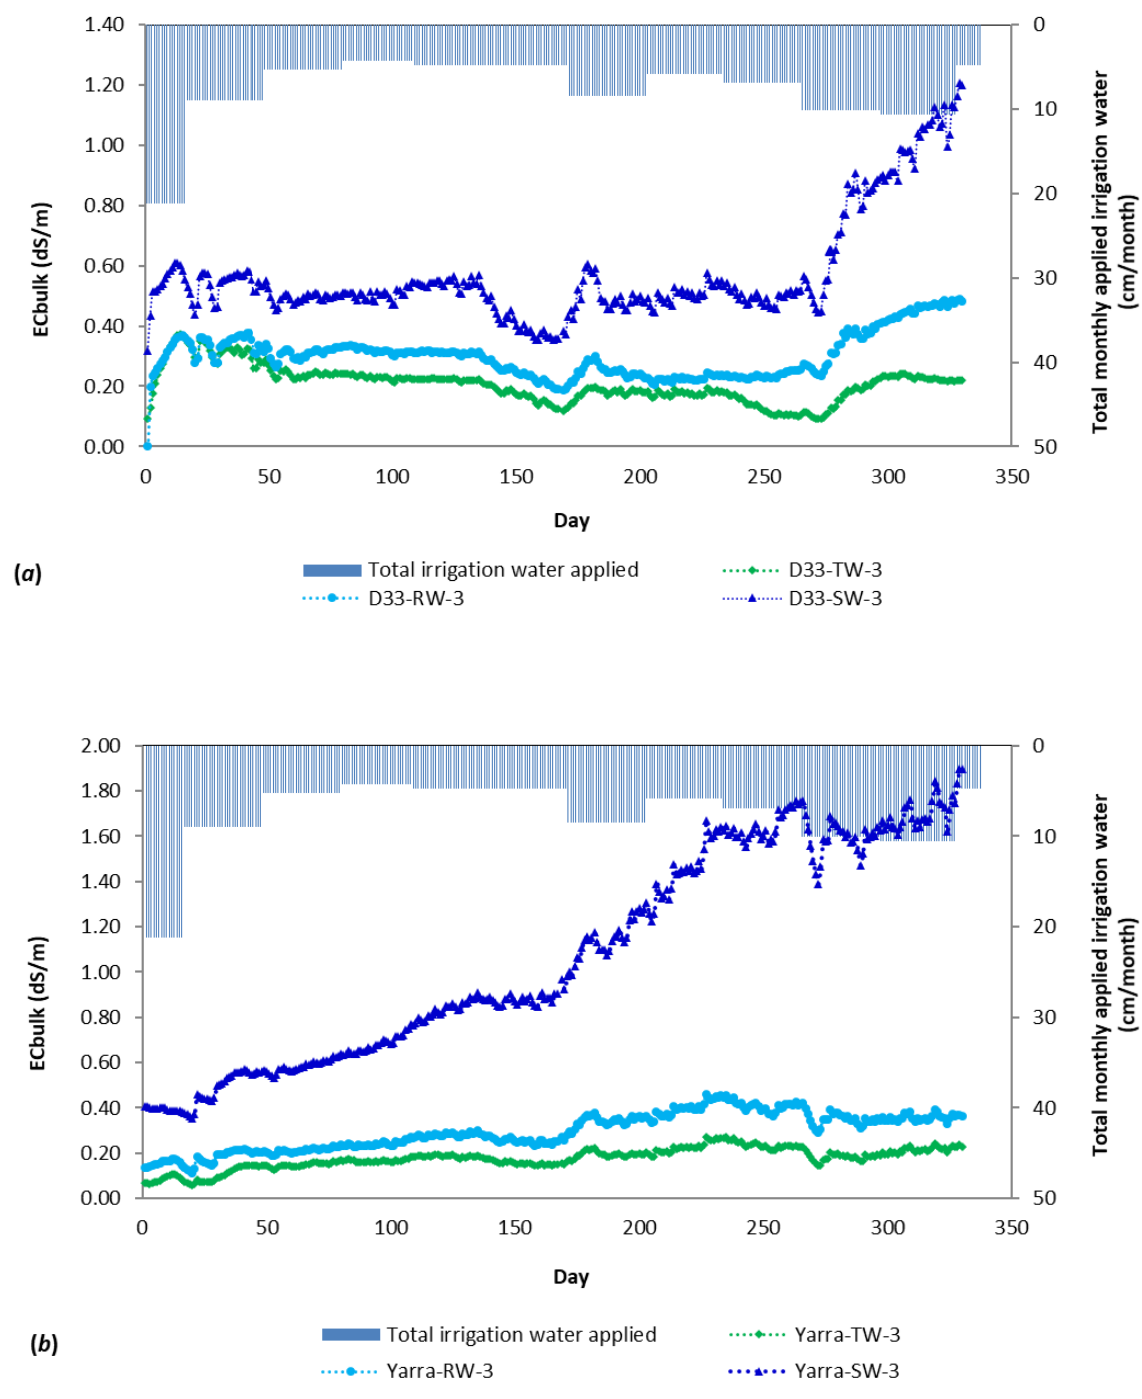
Figure 4. Variation of bulk electrical conductivity at 0.2 m depth measured by GS3 sensor in soil columns using TW, RW and SW as irrigation water (VWC and EC bulk averaged over a day) for (a) D33 paddock soil (b) Yarramundi paddock soil.